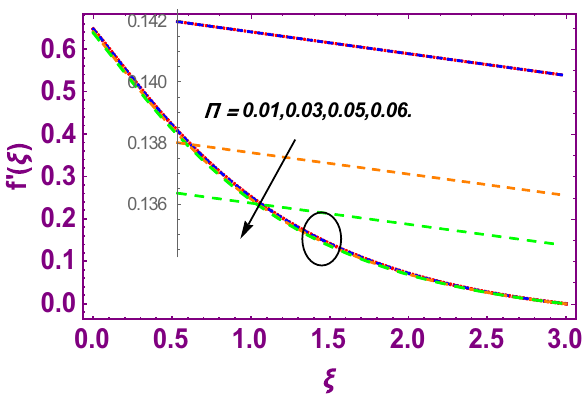
Figure 2. Effect of (cid:31) on f ′ (ξ) .